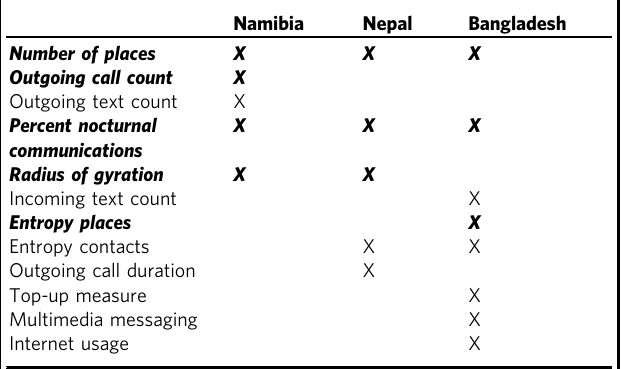
Table 5 Mobile phone data used in country-speci fi c and generalized poverty models.